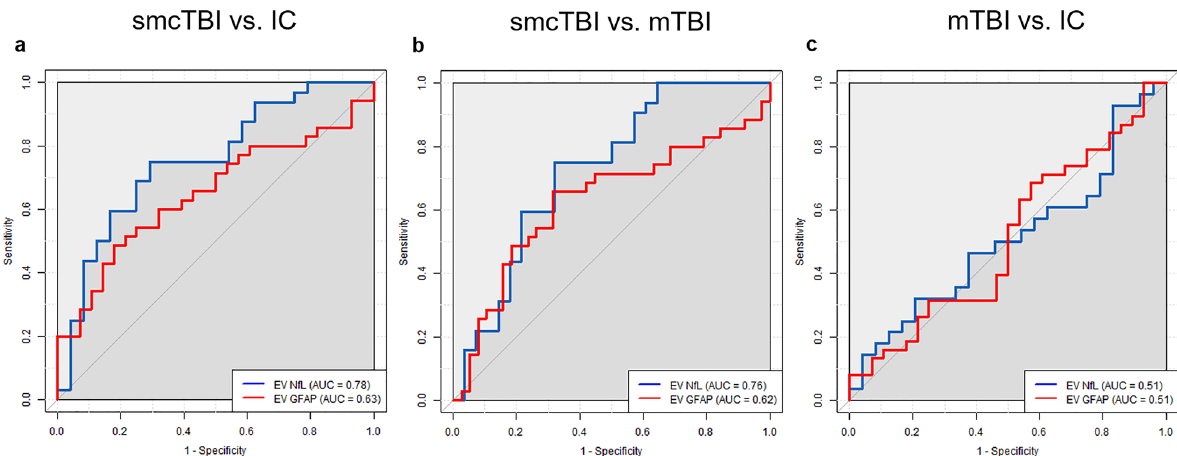
Figure 2. Univariate area under the receiver operating characteristic curves (AUCs) for EV NfL (blue) and EV GFAP (red) within one year after injury comparing smcTBI versus IC ( a ), smcTBI versus mTBI ( b ), and mTBI versus IC ( c ). Grey diagonal line represents reference line (AUC = 0.5). TSI, time since injury; GFAP, Glial fibrillary acidic protein; NfL, Neurofilament light chain; IC, injured controls; mTBI, uncomplicated mild TBI; smcTBI, complicated mTBI, moderate TBI, and severe TBI